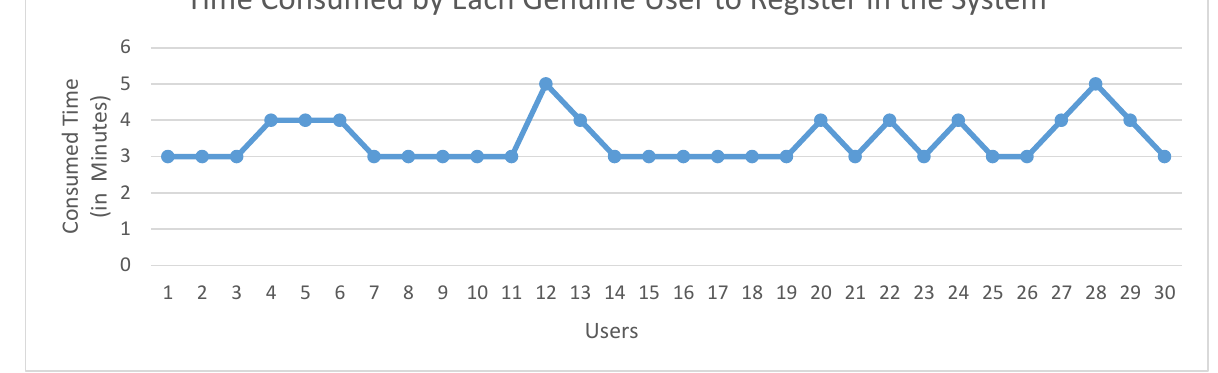
Figure 9. Time consumed by each genuine user .